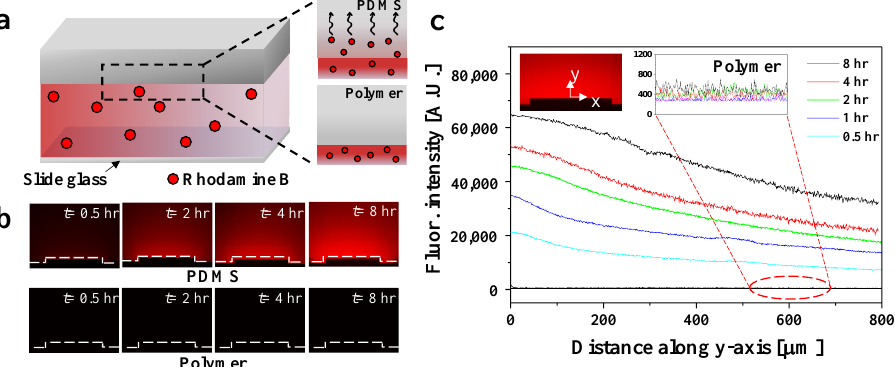
Figure 4. ( a ) Schematic illustration of diffusion of Rhodamine B molecules expressing red fluorescence. Dashed black line shows the adsorption of molecules on the surface of each channel. ( b ) Fluorescence images showing diffusion of Rhodamine B over time. Dashed white line represents the surface of the channels. ( c ) Quantification of fluorescence intensity in each channel. As shown in inset image, fluorescence intensity was measured along the y -axis with respect to the center of the channel. Dashed red line shows measurement of the fluorescence intensity in polymer channels.